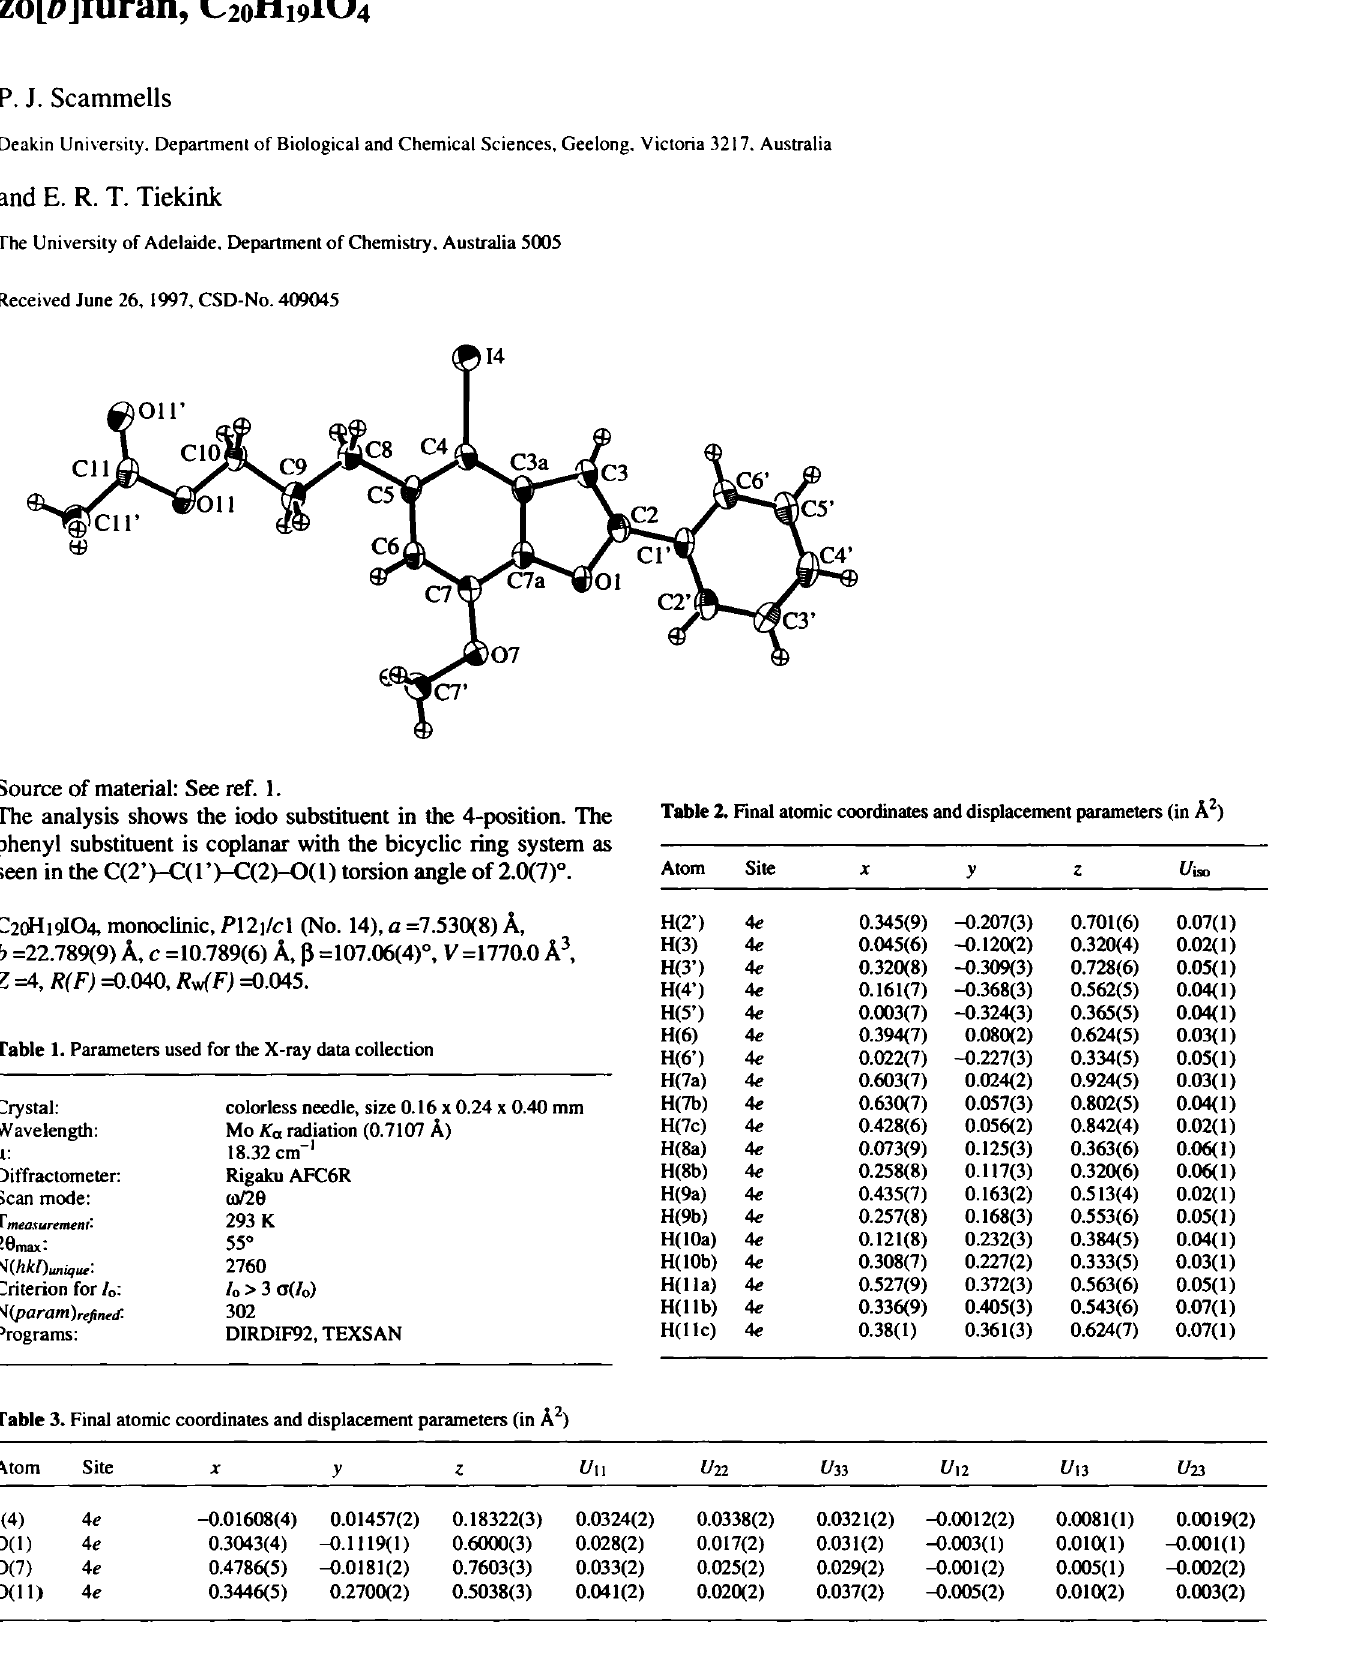
Table 3. Final atomic coordinates and displacement parameters (in Â^) Atom